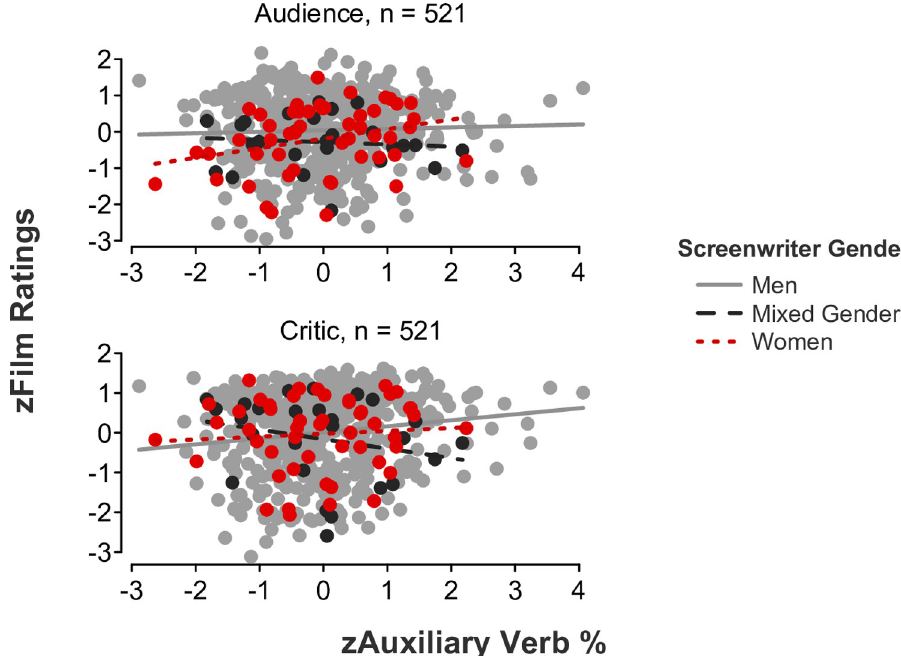
Fig 2. Film ratings as a function of auxiliary verb use, screenwriter gender, and rater role.